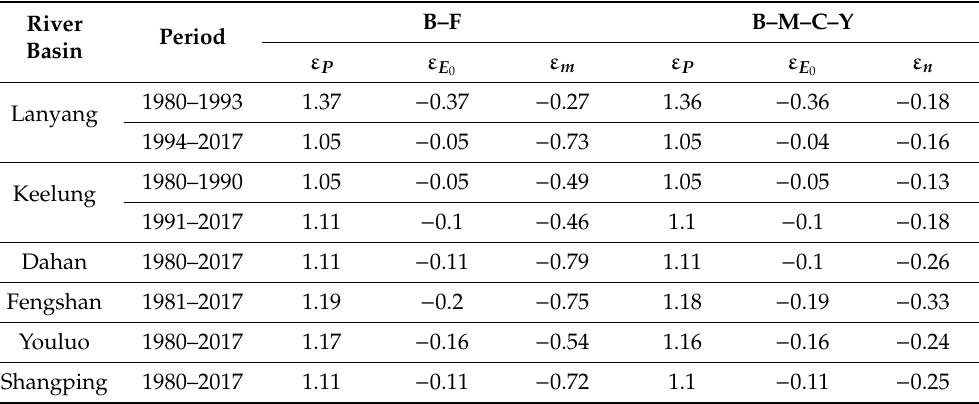
Table 6. Results of the sensitivity analysis of streamflow variation for precipitation, potential evapotranspiration, and watershed characteristics